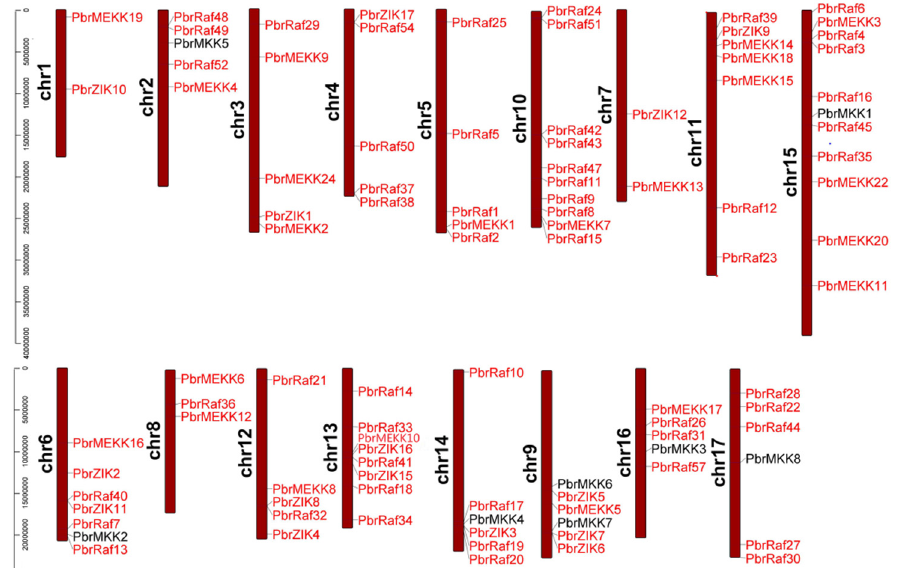
Figure 1. Genomic distribution of PbrMKKs and PbrMAPKKKs on Pyrus chromosomes. The chromosome number is indicated at the left of each chromosome representation. The scale is in base pair (bp).